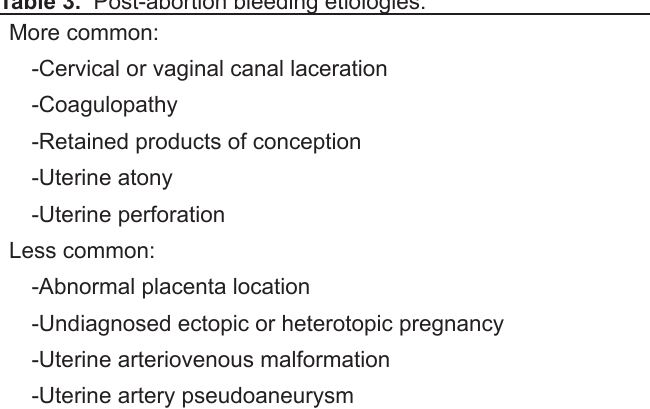
Table 4. Management of uterine atony.